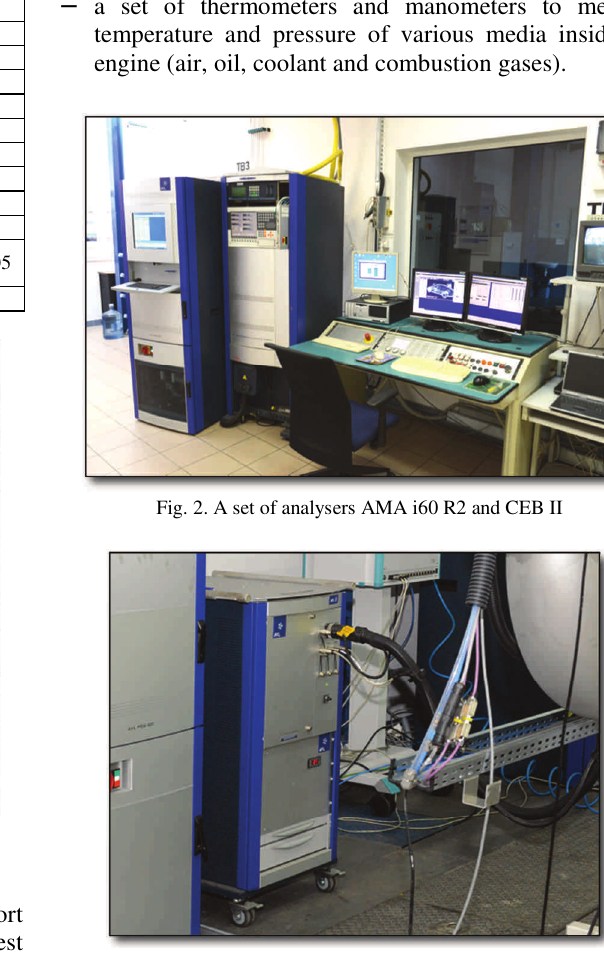
Fig. 3. AVL particulate matter measuring